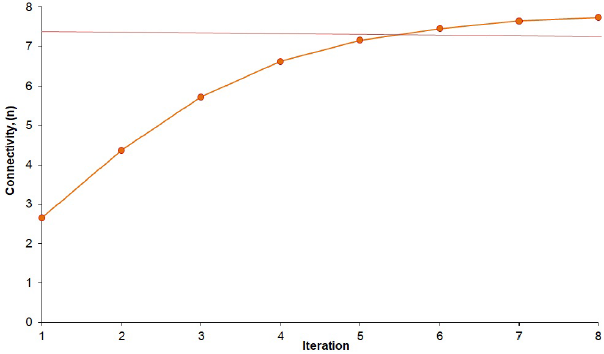
Figure 6. Variation of connectivity with iterations for deterministic fracture-fractal patterns ( i = 1 to